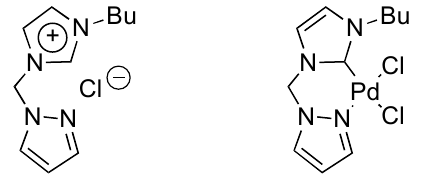
Figure 2. Palladium complex from N-pyrazolyl imidazolium based IL.